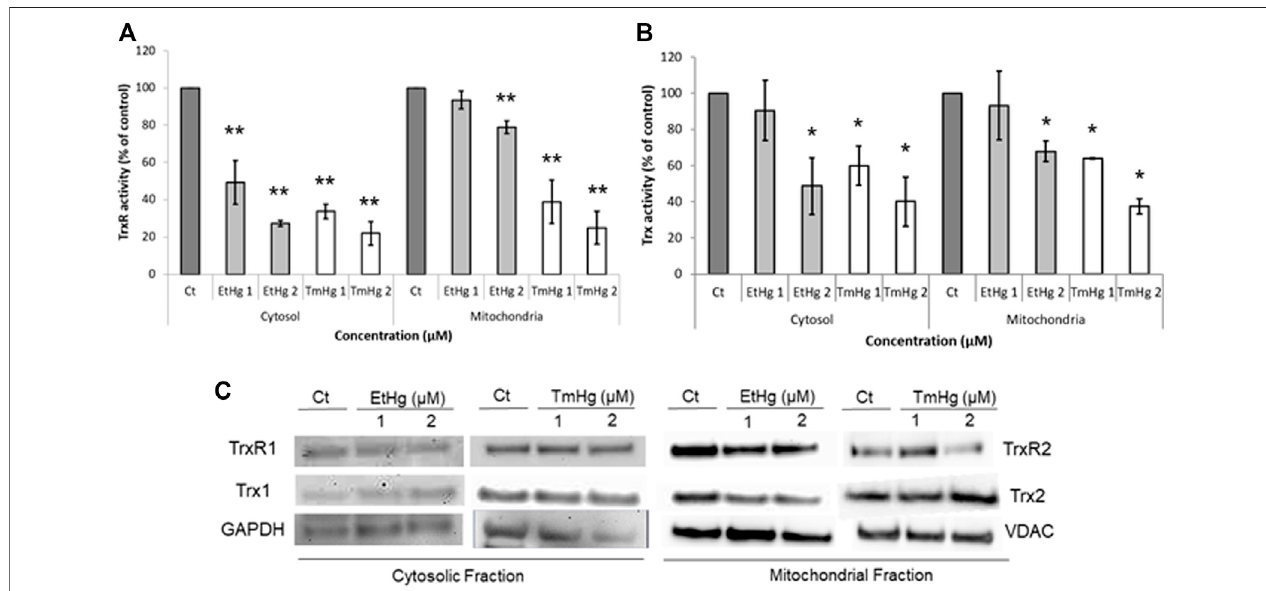
FIGURE 3 | Effect of TmHg and EtHg on TrxR (A) and Trx (B) Activity and Expression (C) in the cytosol and mitochondria of GL261 cells. Cells were exposed to mercurycompounds (1and 2 µM)for24 hand activities weremeasured bytheinsulinend-pointassayinthecytosoland mitochondriaafter theseparationoforganelles as described in materials and methods. Expression levels weredetermined bywestern blots and results werenormalized forprotein loading on thegel withGAPDH and VDAC for cytosol and mitochondria, respectively, and Ponceau-S. Data in A and B are expressed as activity relative to non-treated control and the values are mean ± SEM of three to four independent experiments. Data in C demonstrate the blots. p p < 0.05, pp p < 0.01 from non-treated control